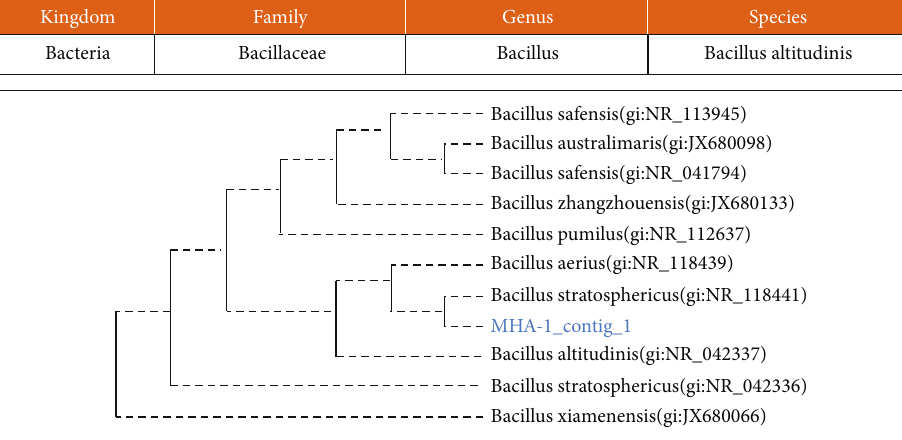
Figure 3: The phylogenetic study of isolate MHA-1/MHA